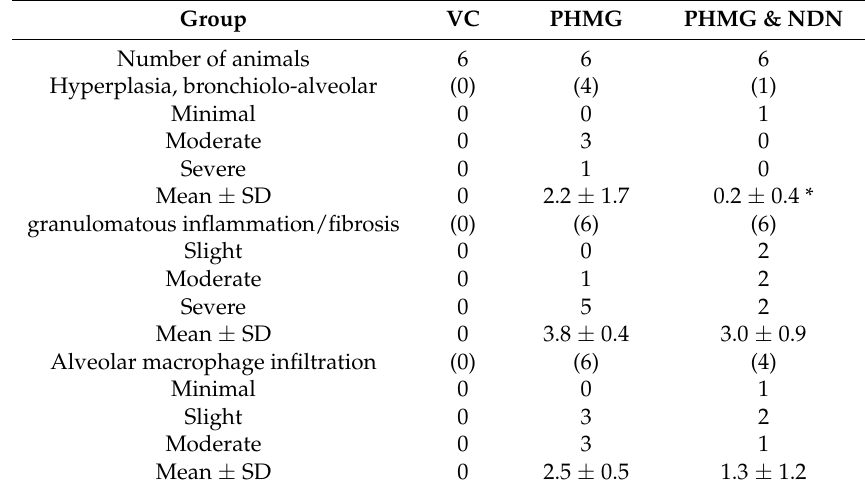
Table 1. Quantitative histopathological assessment of the lung sections.